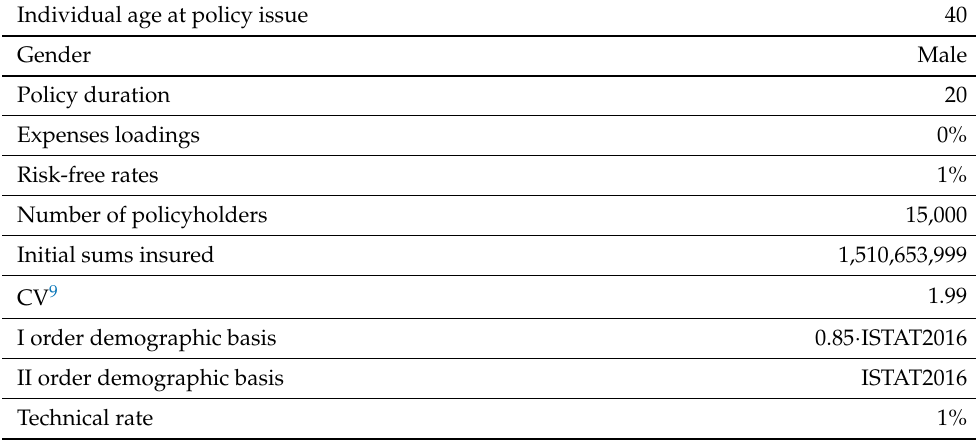
Table 1. Model parameters.